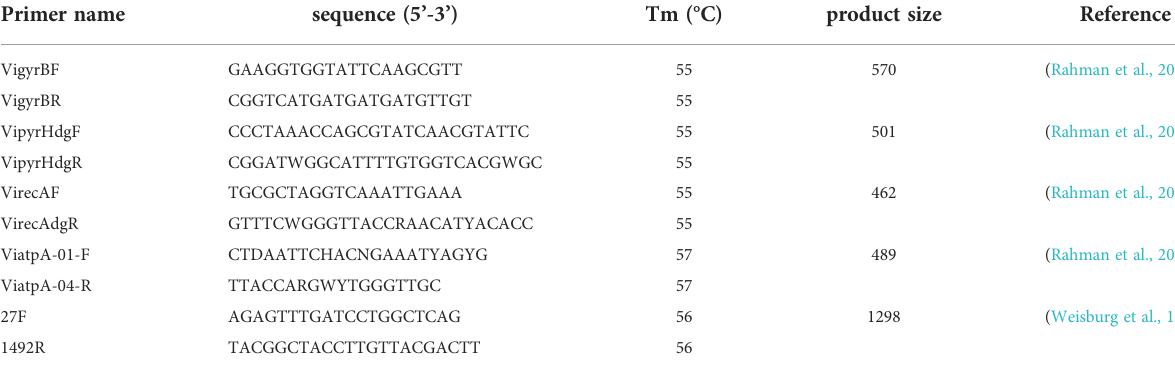
TABLE 1 Primers used for ampli fi cation and sequencing of Harveyi clade